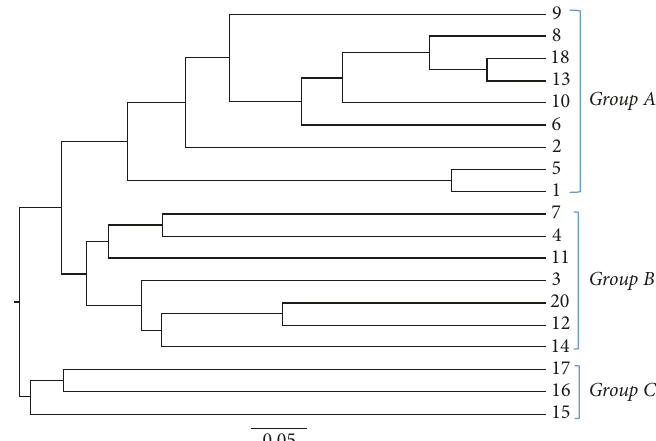
Figure 2: Phylogenetic tree dendrogram based on 16S rRNA gene from 19 primary endodontic patients for comparison of bacterial com- munities which demonstrated three separate community structure and population compositions (Groups A, B, and C).